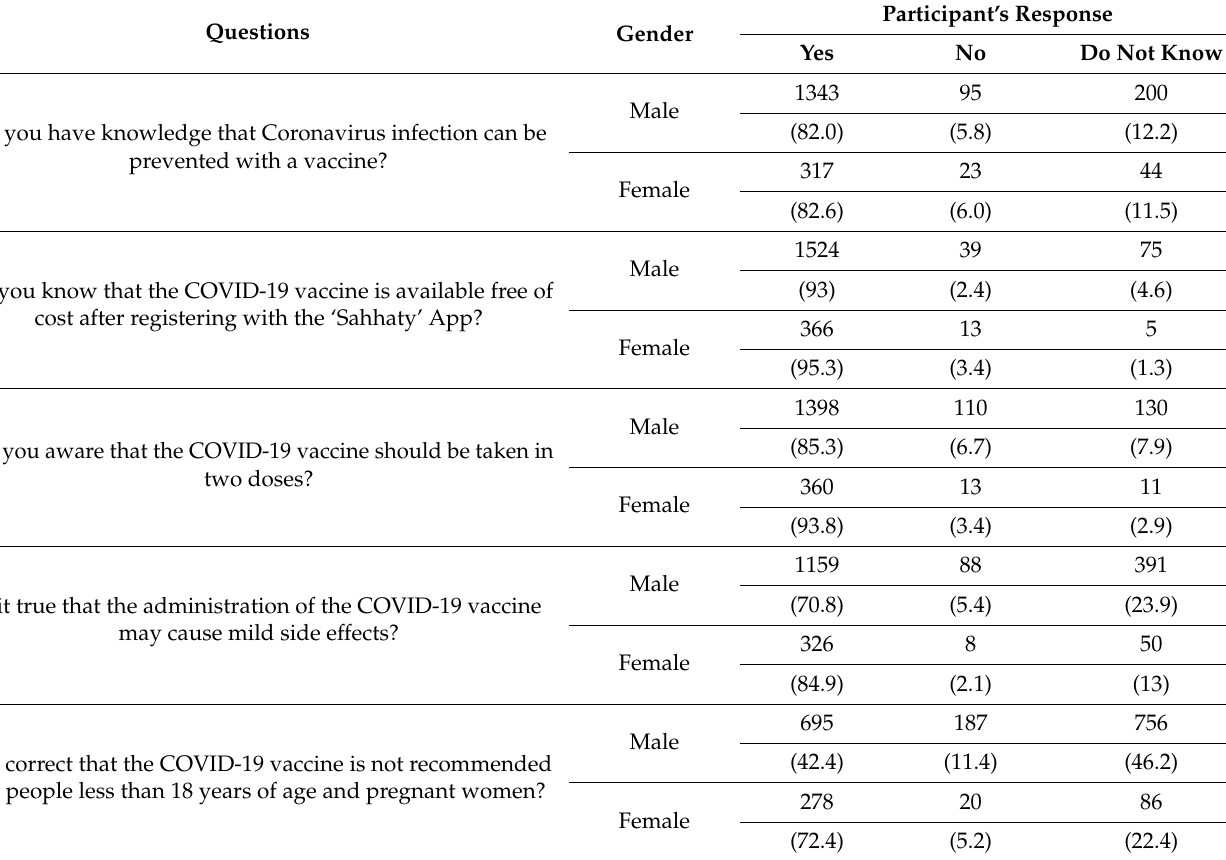
Table 2. Frequency of response for the knowledge questions by the